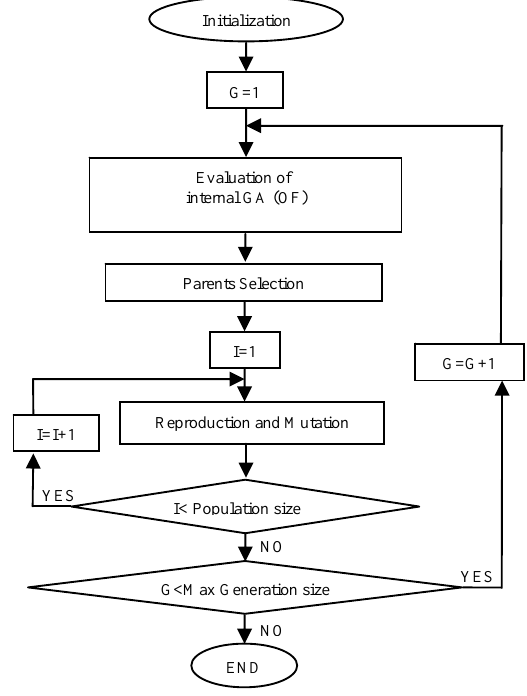
Fig. 1. Flow diagram of GA used in this